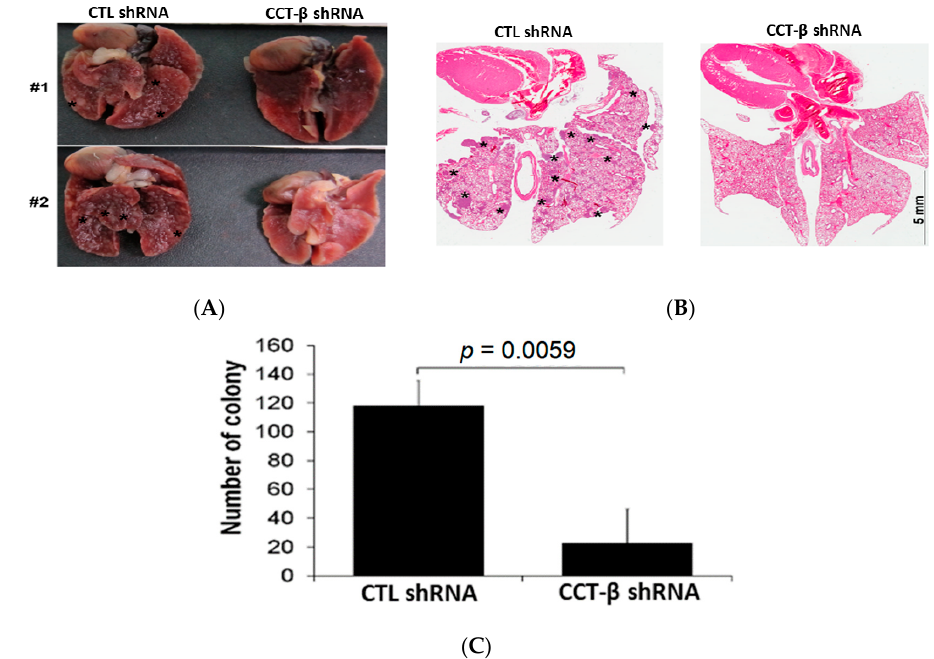
Figure 6. CCT- ꞵ knockdown suppressed lung colony formation through the migration of MDA-MB-231 cells in tumor-bearing mice. ( A ) The appearance of tumor nodules in the lungs derived from 2 representative mice transplanted with MDA-MB-231 cells without or with CCT- ꞵ knockdown. ( B ) H/E staining for tumor colonies in the lungs from mice transplanted with MDA-MB-231 cells without or with CCT- ꞵ knockdown. ( C ) The colony number from the tumor-bearing mice ( n = 5) is presented as the mean ± SEM. The Mann-Whitney U test was used to analyze the statistical significance.